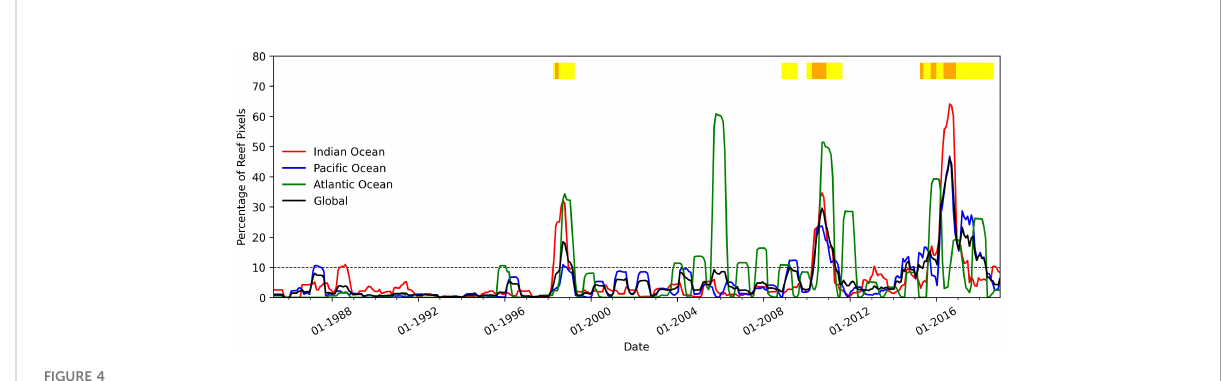
FIGURE 4 As for Figure 3 using a 4-month detection window applied to the 5-km CoralTemp dataset for the period